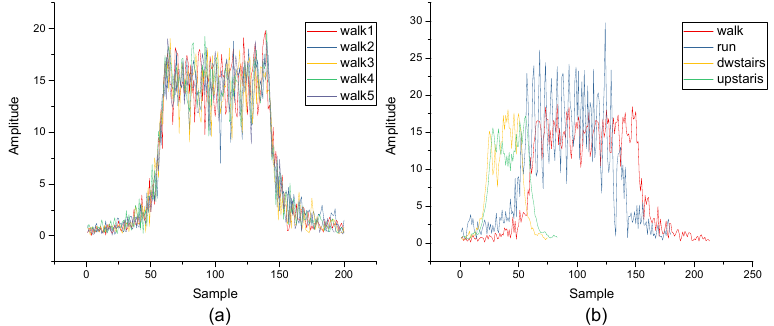
Figure 3. ( a ) The results of FRFT of walking in 0.7 order. ( b ) The results of FRFT of different actions in 0.7 order.